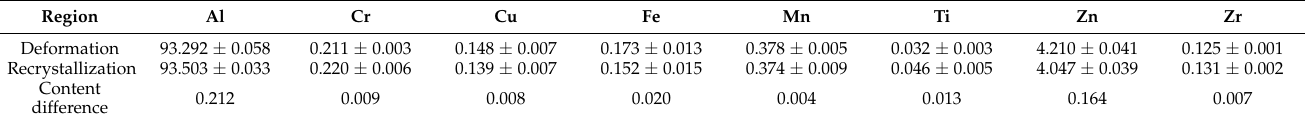
Table 7. The differences in the contents between recrystallization and deformation microstructures (wt%).